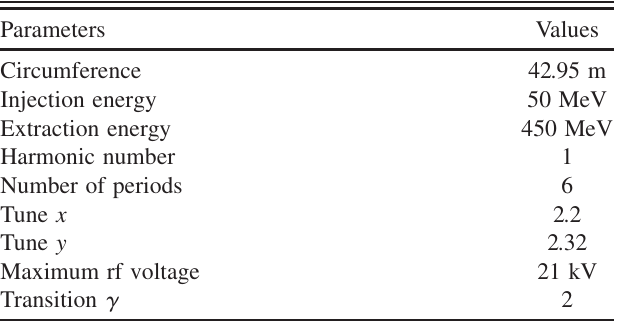
TABLE I. IPNS RCS